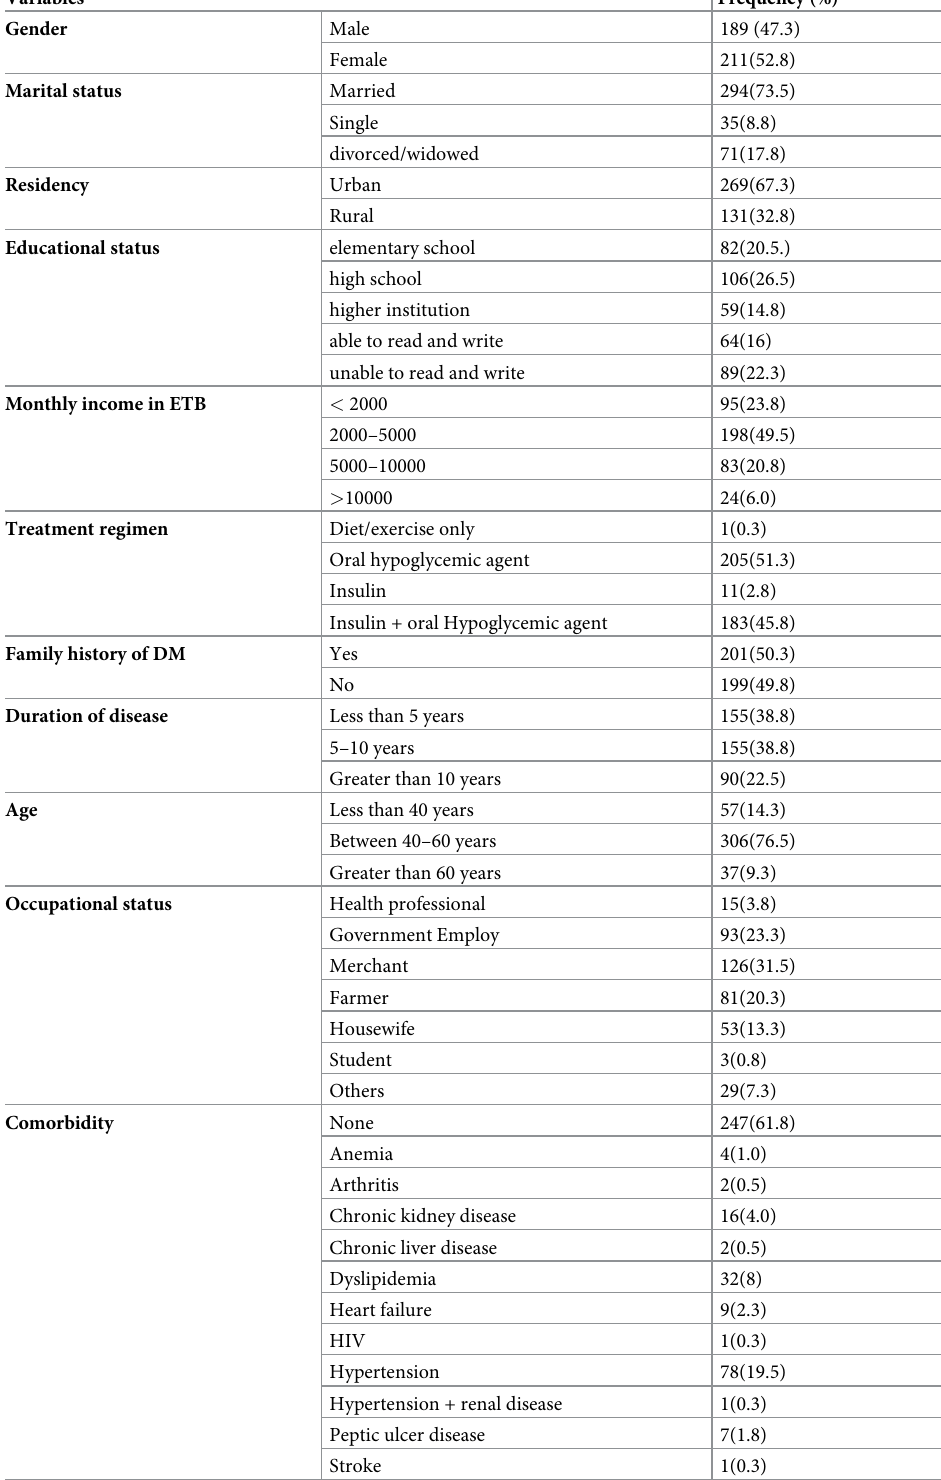
Table 1. Socio-demographic characteristics and clinical information of the diabetic patients at the outpatient clinic of UOGCSH, 2019 (N =